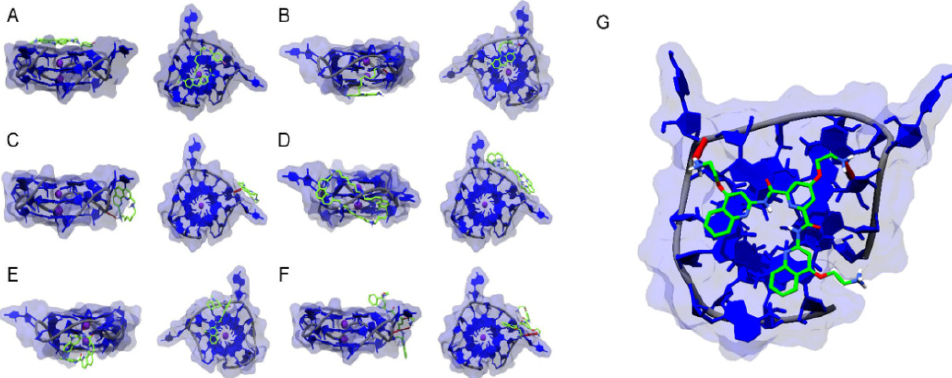
Figure 7. Computational models showing the lowest energy binding poses of the complexes between the prediction model of RNA G4 formed into pre-miRNA-149 and the ligands ( A ) C 8 , ( B ) C 8 -NH 2 , ( C ) (16)phenN 2 , ( D ) (32)phen 2 N 4 , ( E ) PhenDC3 and ( F ) PDS. ( G ) Alternative binding pose of the complex formed by pre-miRNA 149 and PDS after 100 ns of MD simulations. G4 structure is depicted in blue, while ligands are highlighted in green and red. Reprinted with permission from ref. [115] Copyright 2020 Taylor & Francis Group.